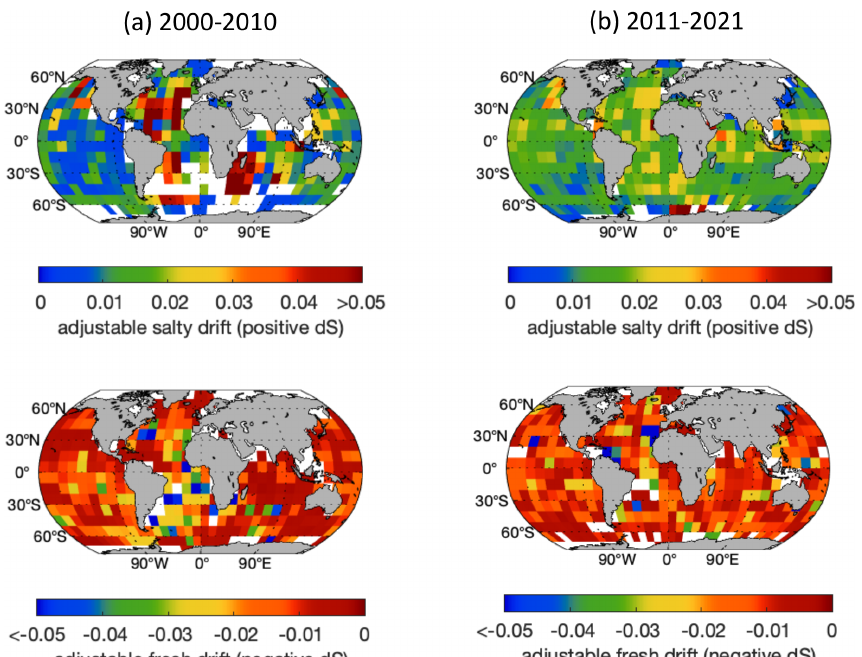
Figure 3. Spatial distribution of Argo delayed-mode salinity adjustments, as of April 2022. (a) 2000–2010. (b) 2011–2021. Top panels show adjustable salty drift (positive ∂S ). Bottom panels show adjustable fresh drift (negative ∂S ). Colors indicate the mean of ∂S in each 10 ◦ × 10 ◦ grid square. White color denotes areas with no Argo data or no appropriate ∂S at the time of this